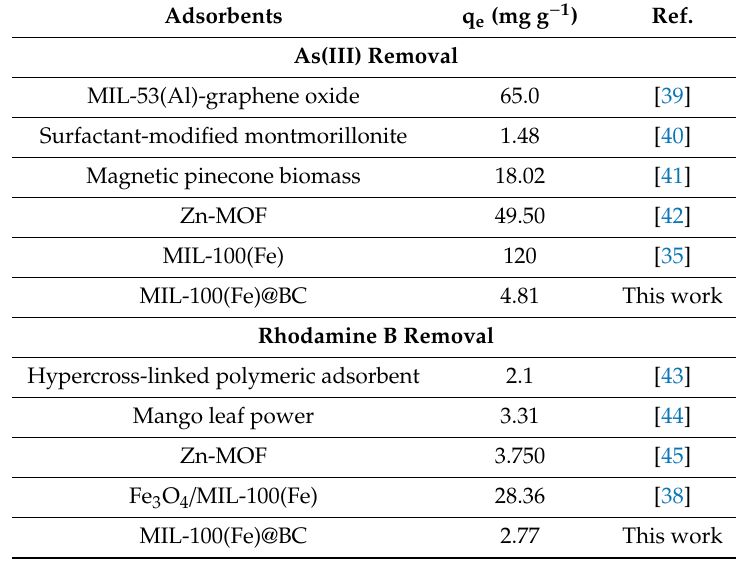
Table 1. Comparison of As(III) and Rhodamine B removal with other reported adsorbents.